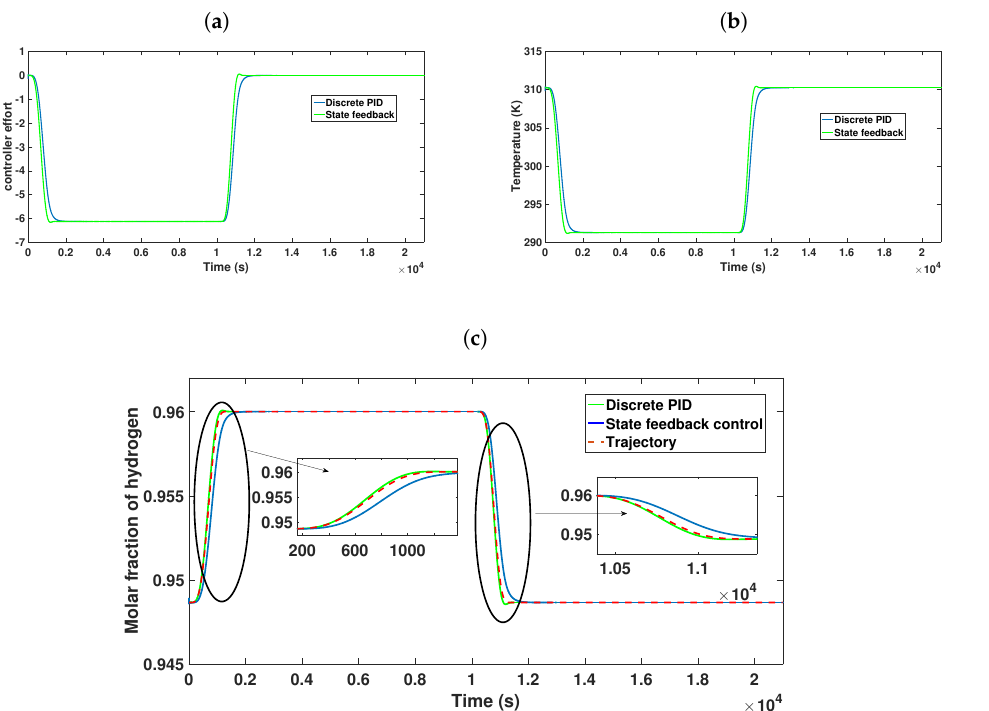
Figure 14. Control signals to reach different purity values and verify the performance of the con- trollers. ( a ) Control signals generated before the block of inverse input functions. ( b ) Control signals generated using the input inverse functions block. ( c ) Hydrogen purity obtained from 2 trajec- tory